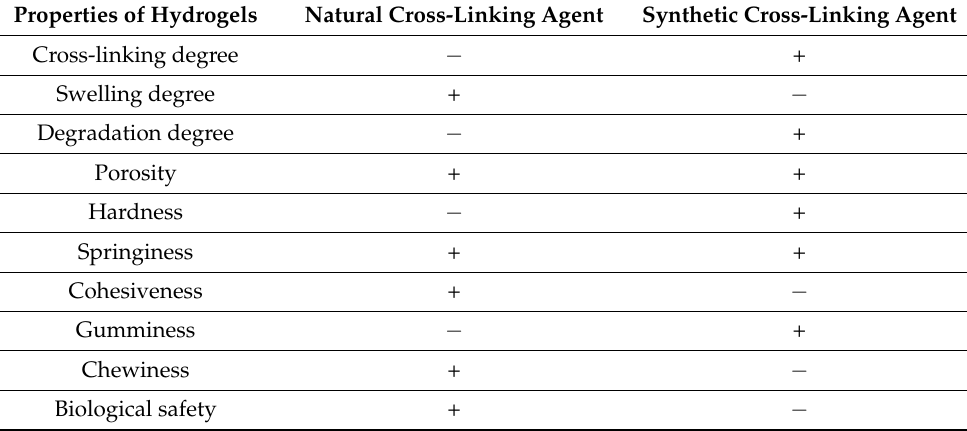
Table 2. Comparison of the properties of the hydrogels that were chemically cross-linked with synthetic or natural cross-linking agents.